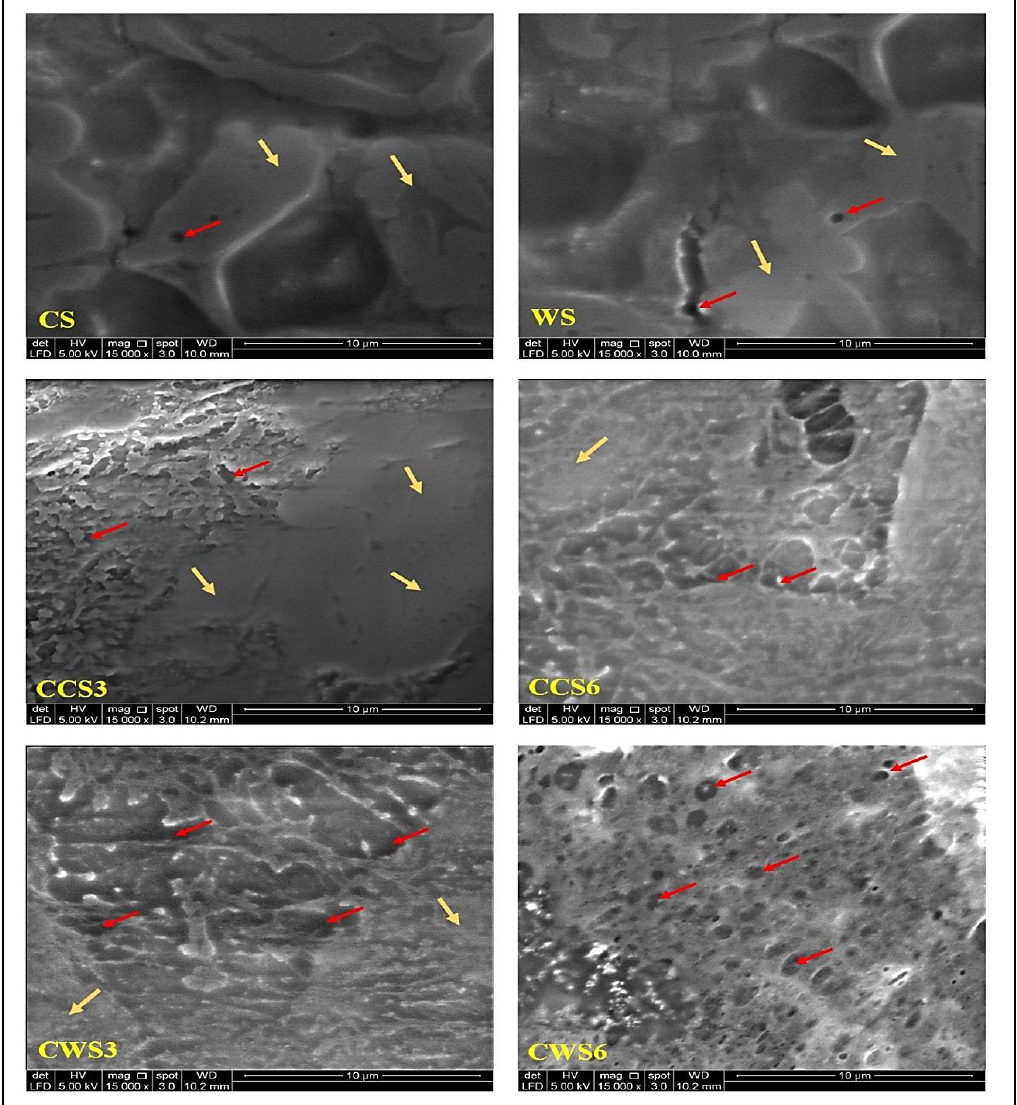
Figure 3. Surface morphology of prepared hydrogel samples under SEM at 15k magnification power; the red arrows show the porous surfaces and the yellow ones show the smooth surfaces.